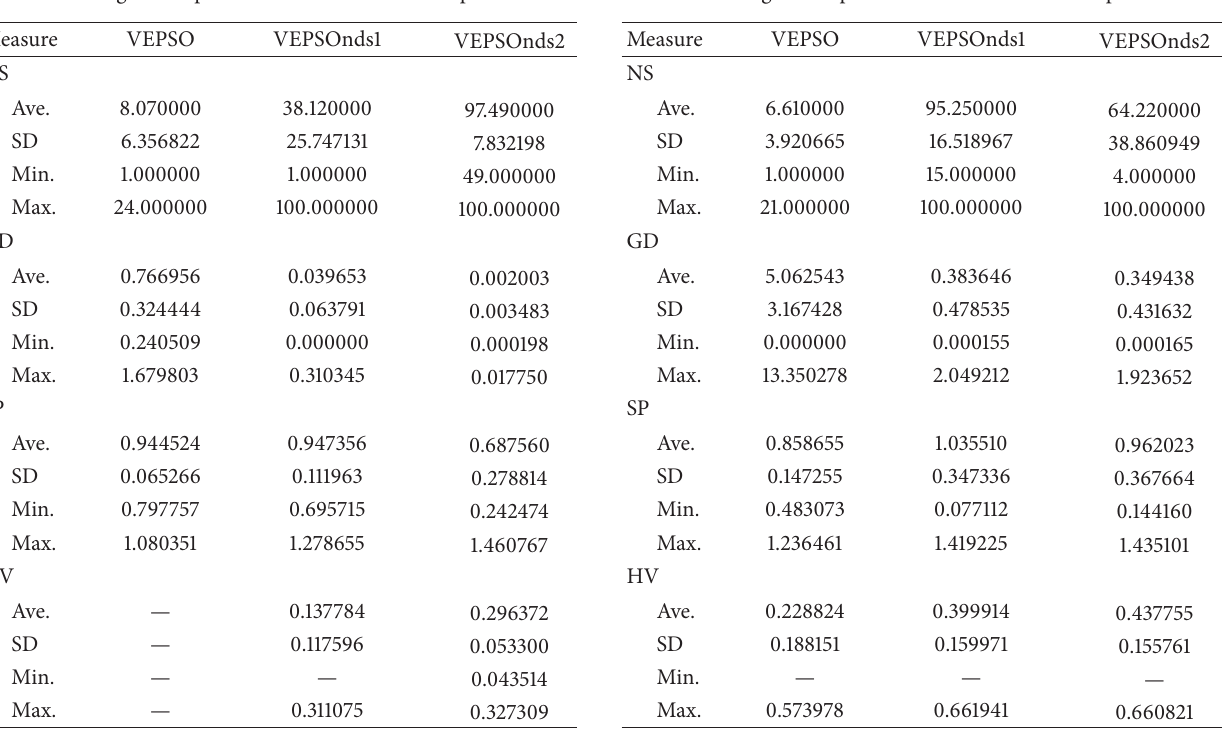
Table 4: Algorithm performance tested on ZDT4